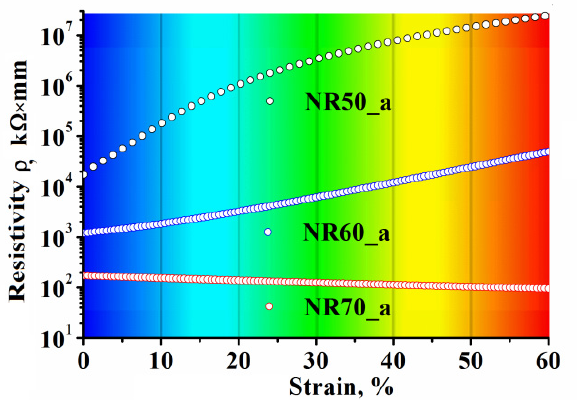
Figure 11. The resistivity of reference samples containing 50 phr CB, 60 phr CB and 70 phr CB vs. the sample’s strain and corresponding DIC domain’s color. Table 2. The calculated resistivity and resistance of separate domains (samples type b).